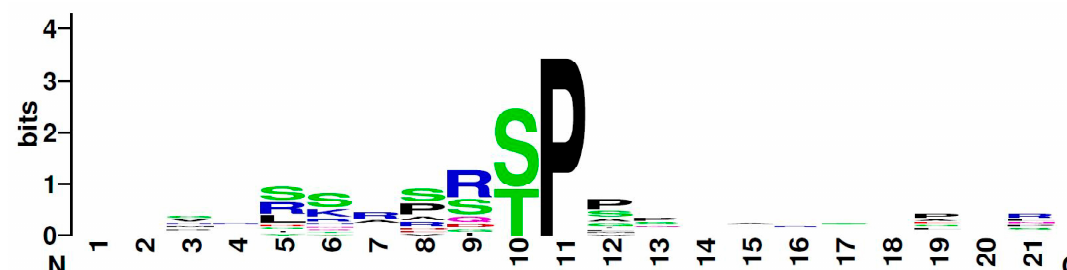
Figure 5. Graphical representation (logo) of the amino acid sequence from Drosophila Hipk substrates. The total height indicates the degree of sequence conservation at the corresponding position. The height of individual letters shows the relative frequency of an amino acid at this position. The Hipk consensus, according to the known Hipk substrates in Drosophila (Twin of eyeless, Eyeless, Groucho, Nito, Homeobrain, Empty spiracles, Muscle segment homeobox, Yorkie). The protein sequences of the substrates were aligned on the kinase-guiding proline. The graphic was created online at www.weglogo.berkeley [40].